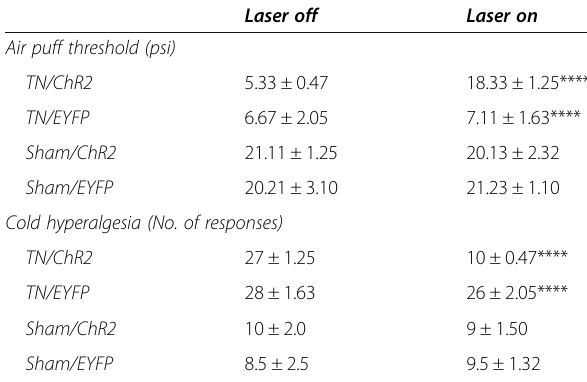
Table 2 Effect of vlPAG optogenetic activation in mechanical and thermal pain sensitivity on trigeminal facial area Laser